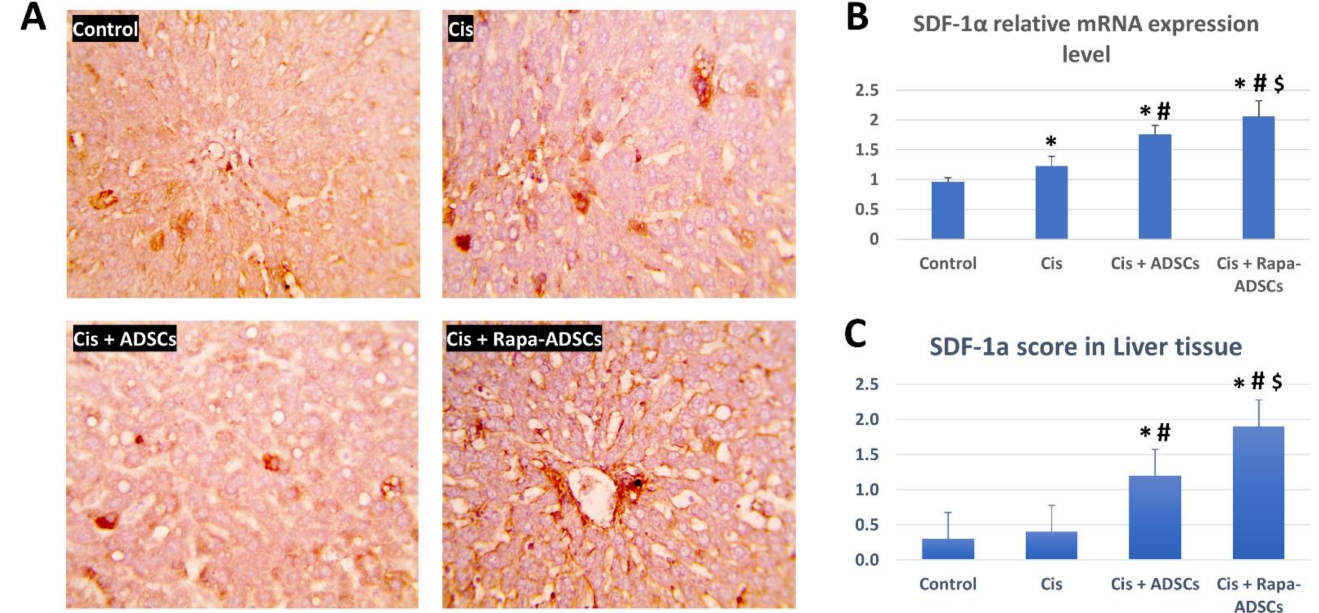
Figure 8. The effects of administering rapamycin-preconditioned ADSCs on liver SDF-1 α gene expression and liver tissue levels in cisplatin (Cis)-induced liver damage. ( A ) Immunohistochemical staining of SDF-1 α in the liver tissue in the different groups, magnification 400 × . ( B ) SDF-1 α relative mRNA expression in the study groups. ( C ) SDF-1 α score from the images in ( A ) from the different studied groups. Cis, cisplatin (i.p. injection of 5 mg/kg in 0.9% saline) group; Cis + ADSCs, cisplatin group receiving ADSCs (one million cells, intravenous in tail vein); Cis + Rapa-ADSCs, cisplatin group receiving same number of ADSCs preconditioned with rapamycin (50 nM/L, 2 h prior to administration). Statistical significance, * vs. control group ( p < 0.01), # vs. Cis group ( p < 0.01) and $ vs. Cis+ADSCs group ( p <